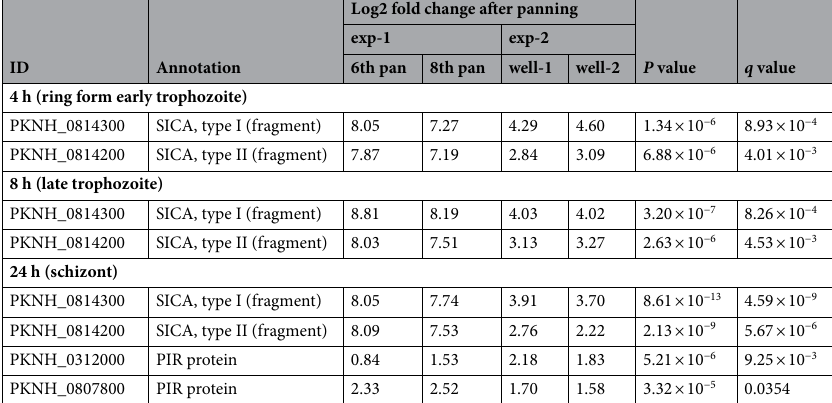
Table 1. Identified P. knowlesi ORFs whose transcript expression was significantly increased. ORFs satisfying the following criteria are shown: (1) whose average FPKM of all data was at least 10, (2) average fold change values were at least 4, and (3) q value is less than 0.05. P and q values were obtained excluding the exp-1 6th pan data.